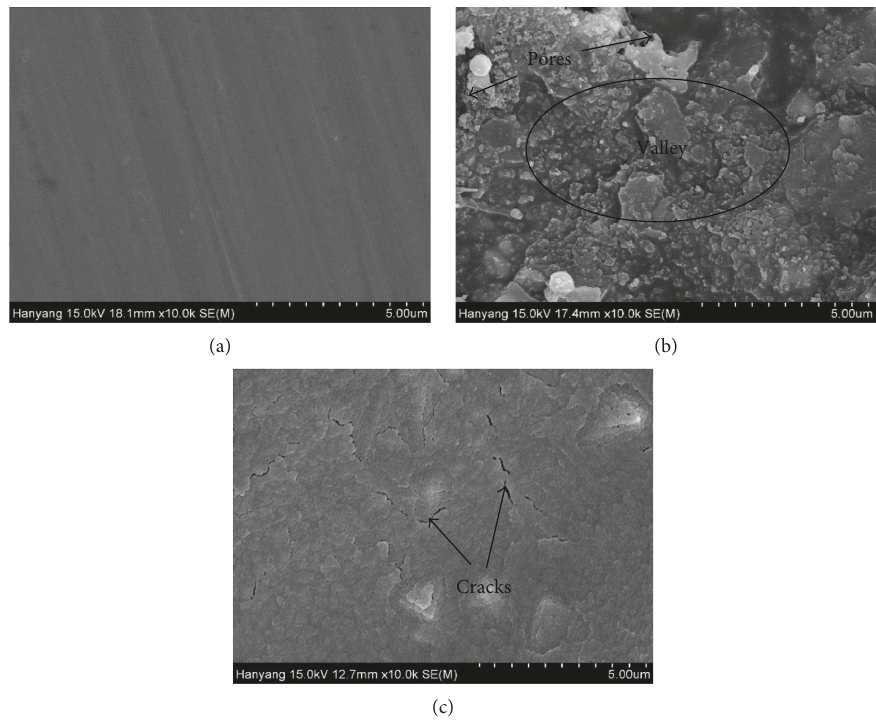
Figure 2: FE-SEM images of the (a) SS plate, (b) SS-sprayed surface, and (c) Ti-sprayed